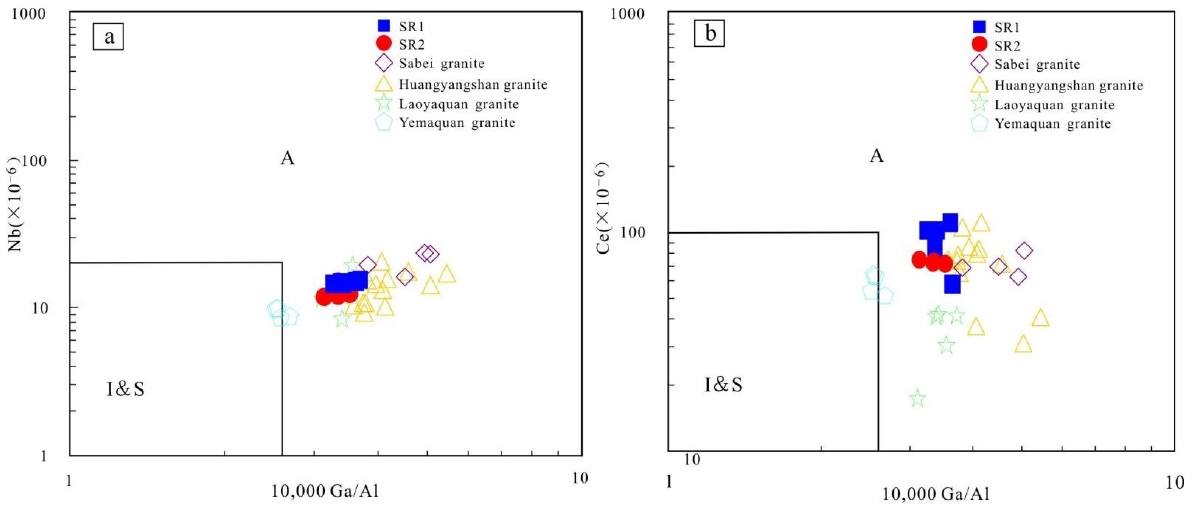
Figure 9. Nb-10,000 Ga/Al diagrams ( a ) and Ce-10,000 Ga/Al diagrams ( b ) for the medium-fine- grained granites and granite porphyry in the Sayashk Sn deposit. (After [86]). Sabei granite after [30], Huangyangshan granite after [75], Laoyaquan granite after [9], Yemaquan granite after [70].